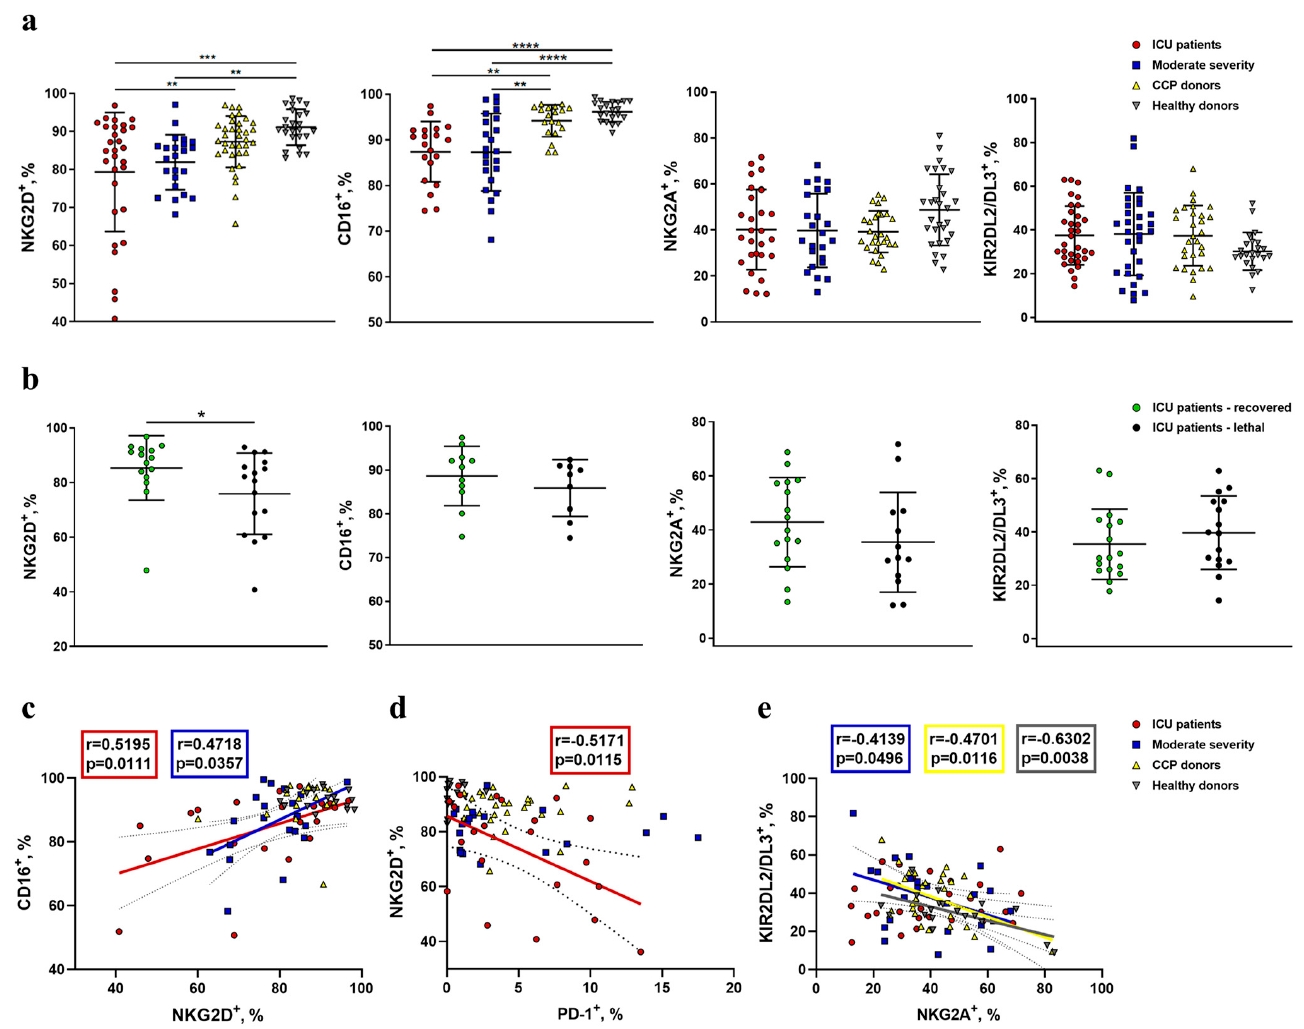
Figure 5. Analysis of NKG2D, CD16, NKG2A, and KIR3DL2/DL3 expression in NK cells from COVID-19 patients, convalescent patients, and healthy donors. ( a ) The proportion of NKG2D + , CD16 + NKG2A + , and KIR3DL2/DL3 + NK cells measured in the following comparison groups: ICU patients (n = 32, n = 20, n = 27, and n = 27, respectively), moderate-severity patients (n = 23, n = 23, n = 24, and n = 24, respectively), CCP donors (n = 35, n = 20, n = 27, and n = 27, respectively), and healthy donors (n = 27, n = 21, n = 29, and n = 29, respectively). ( b ) Comparative analysis of NKG2D + , CD16 + , NKG2A + , and KIR3DL2/DL3 + NK cells in recovered and lethal ICU patients from the ICU group. ( c ) Spearman correlation between NKG2D + and CD16 + NK cell levels in all donor groups. ( d ) Pearson correlation between NKG2D + and PD-1 + NK cell levels in all donor groups. ( e ) Pearson correlation between NKG2A + and KIR3DL2/DL3 + NK cell levels in all donor groups. ( a , b ) Data are presented as individual values with mean (±SD). * p < 0.05, ** p < 0.01, *** p < 0.001, **** p < 0.0001.